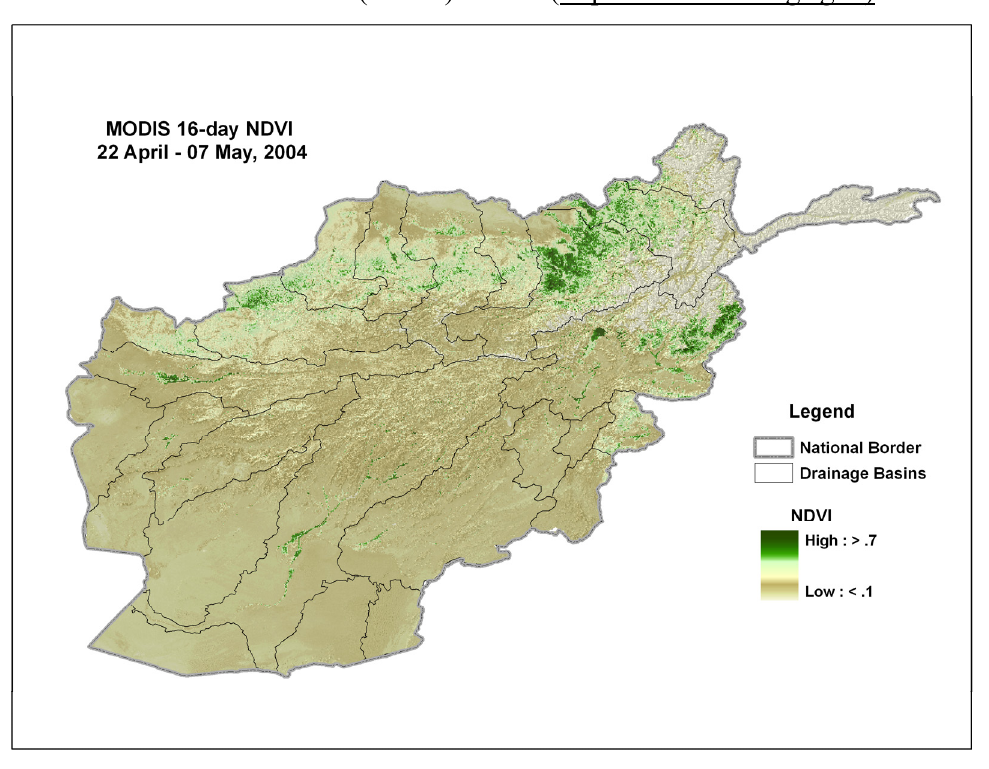
Figure 3. MODIS 250m 16-day NDVI composite in late April/early May